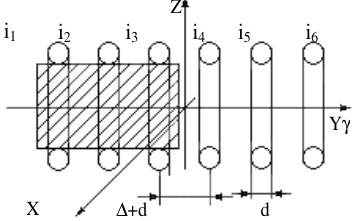
Fig 11. Replacement of three-section coil to six-section coil with infinitely thin conductors